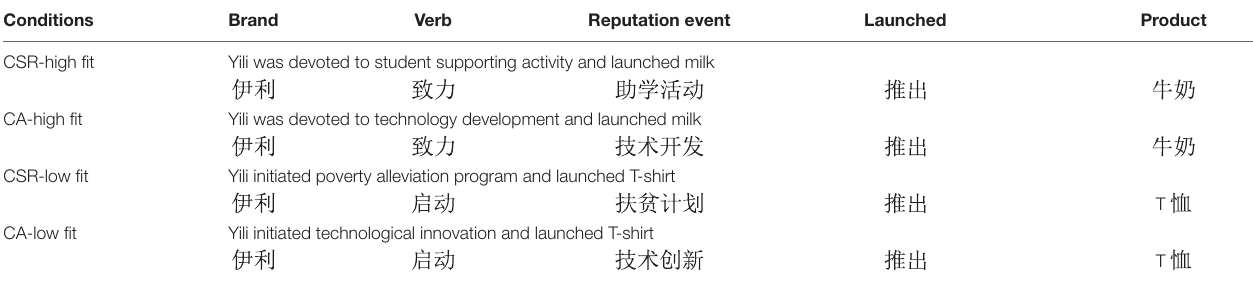
TABLE 1 | Examples of the stimuli sets with four conditions.